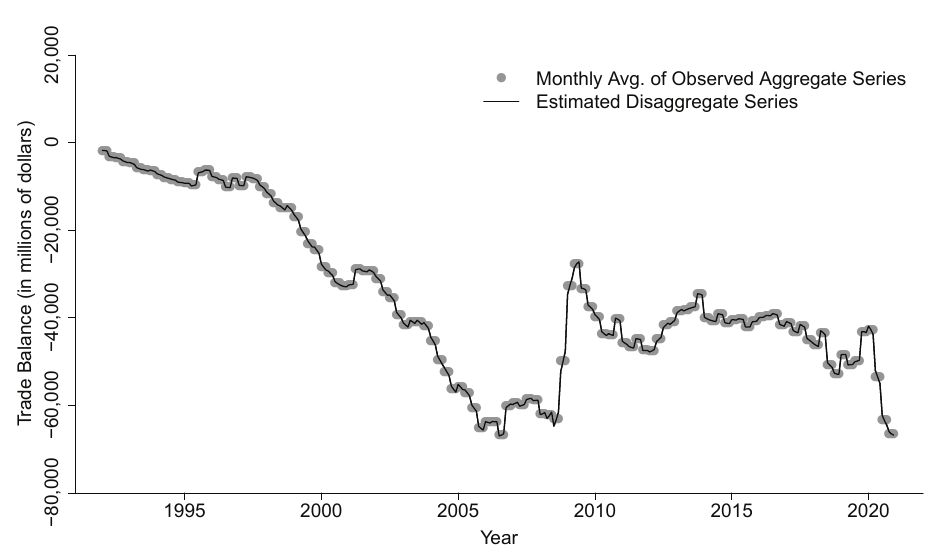
Figure 2. Monthly averages of the observed aggregate series vs. estimated disaggregate series. Next, we construct 95% AR-sieve bootstrap prediction intervals for the unknown monthly trade balances x t . From Steps 1 and 2 in Section 3, assuming τ = 0.001, we select the AR ( 33 ) approximation for ˆ u t = ˆ x t − ˆ u t − 1 , including the coefficient estimates ˆ π 1 = − 0.81301,